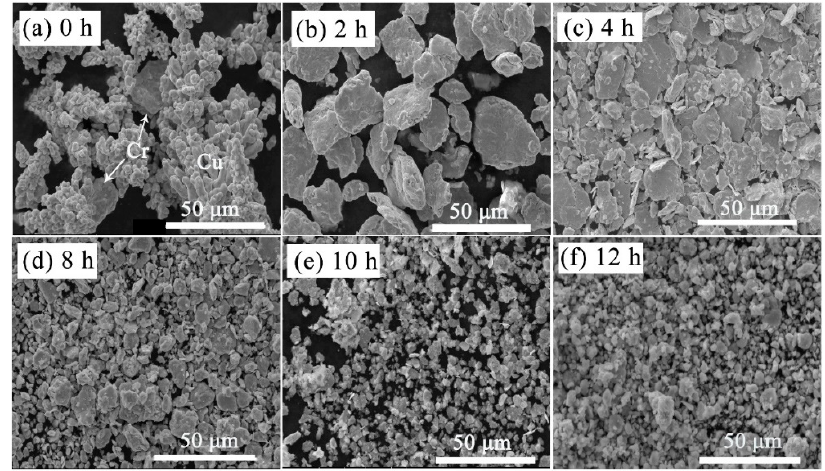
Figure 4. Morphology changes of Cu-Cr powders with the milling time. ( a ) 0 h, ( b ) 2 h, ( c ) 4 h, ( d ) 8 h, ( e ) 10 h, ( f ) 12 h.